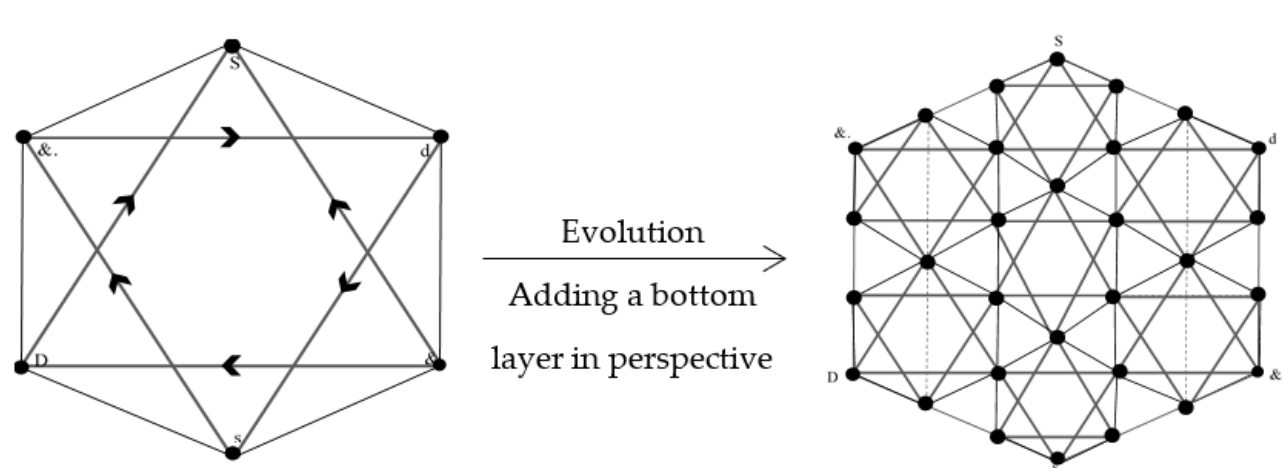
Figure 7. The structure of the model, containing: (a) a source (S), which is generating variation; (b) a sensor (&), which is able to know the essence of the variation; and (c) a decident (D), which is able to decide the subsequent behavior of the source, author's source.